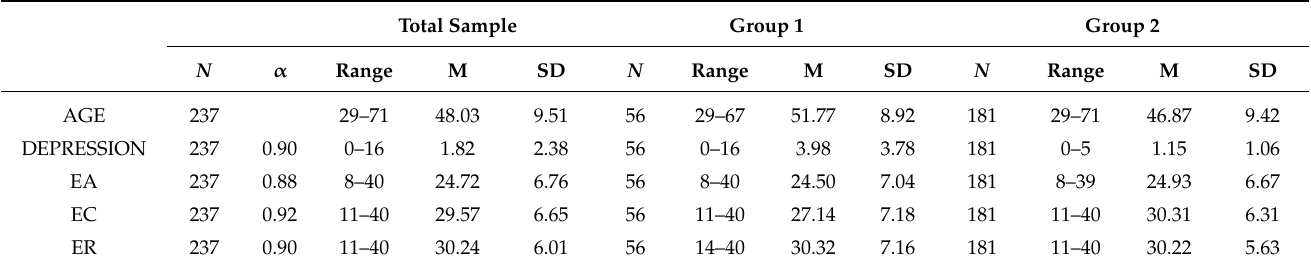
Table 1. Descriptive statistics of all the variables included in the study for the total sample, and both groups separately: Group 1 (breast cancer survivors), and Group 2 (healthy